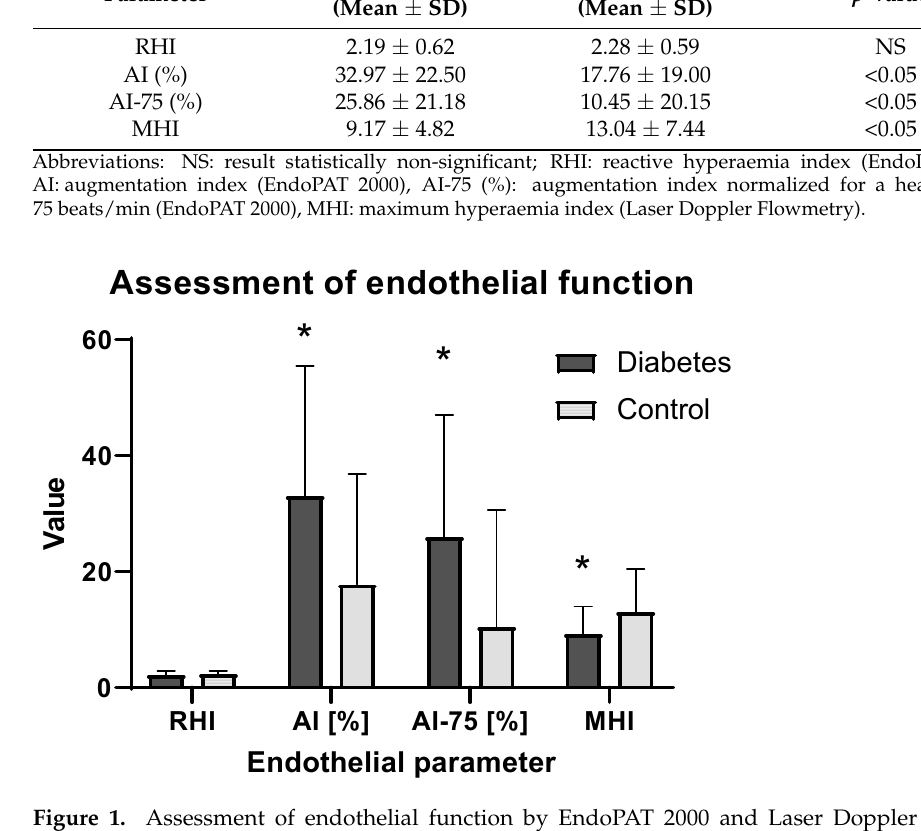
Figure 1. Assessment of endothelial function by EndoPAT 2000 and Laser Doppler Flowmetry. Ab- breviations : RHI: reactive hyperaemia index (EndoPAT 2000); AI (%): augmentation index (Endo- PAT 2000), AI-75 (%): augmentation index normalized for a heart rate of 75 beats/min (EndoPAT 2000), MHI: maximum hyperaemia index (Laser Doppler Flowmetry). Correlation of endothelial function with NO and biochemical metabolites in DM patients. *- p < 0.05 vs. control